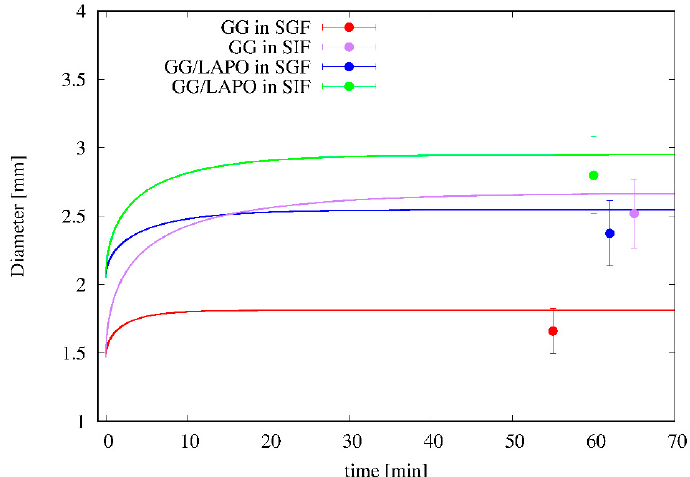
Figure 8. Comparison between the swelling model predictions (continuous lines) and experimental data (points) for the temporal evolution of the particle diameter for two different bead formulations (GG/Ca 0.3% and GG/LAPO/Ca 0.3%) and two different swelling media (SGF and SIF).